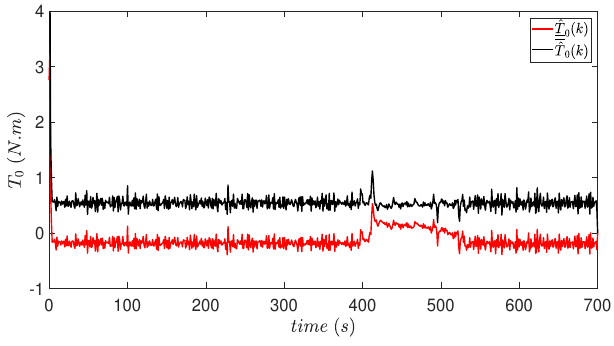
Figure 5. Estimation of T 0 ( k )